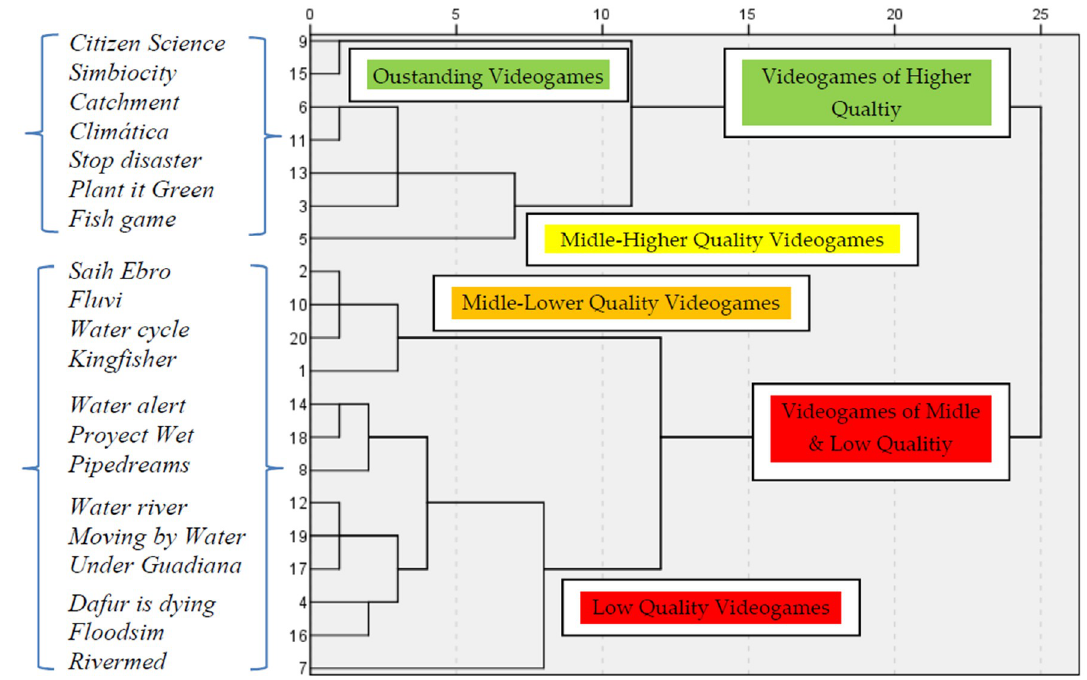
Figure 3. Cluster of Quality Videogames on Water.